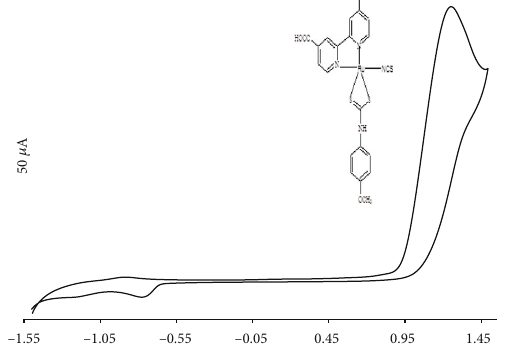
Figure 5: Cyclic voltammogram of FC